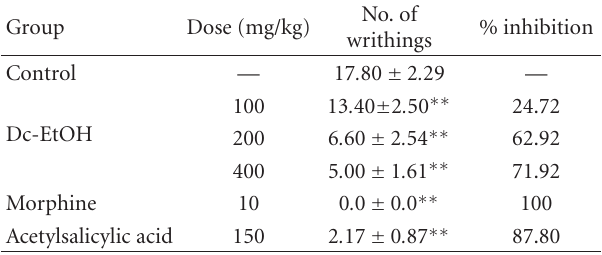
Table 1: Antinociceptive e ff ect of Dc-EtOH on acetic acid-induced writhing in